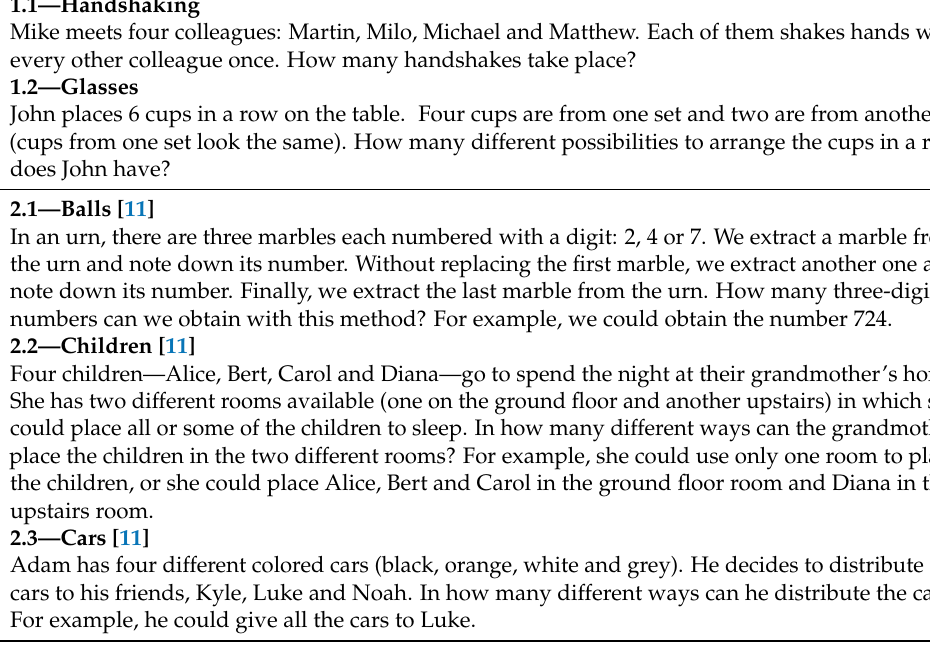
Table 1. Combinatorial MSTs for Sessions 1 and